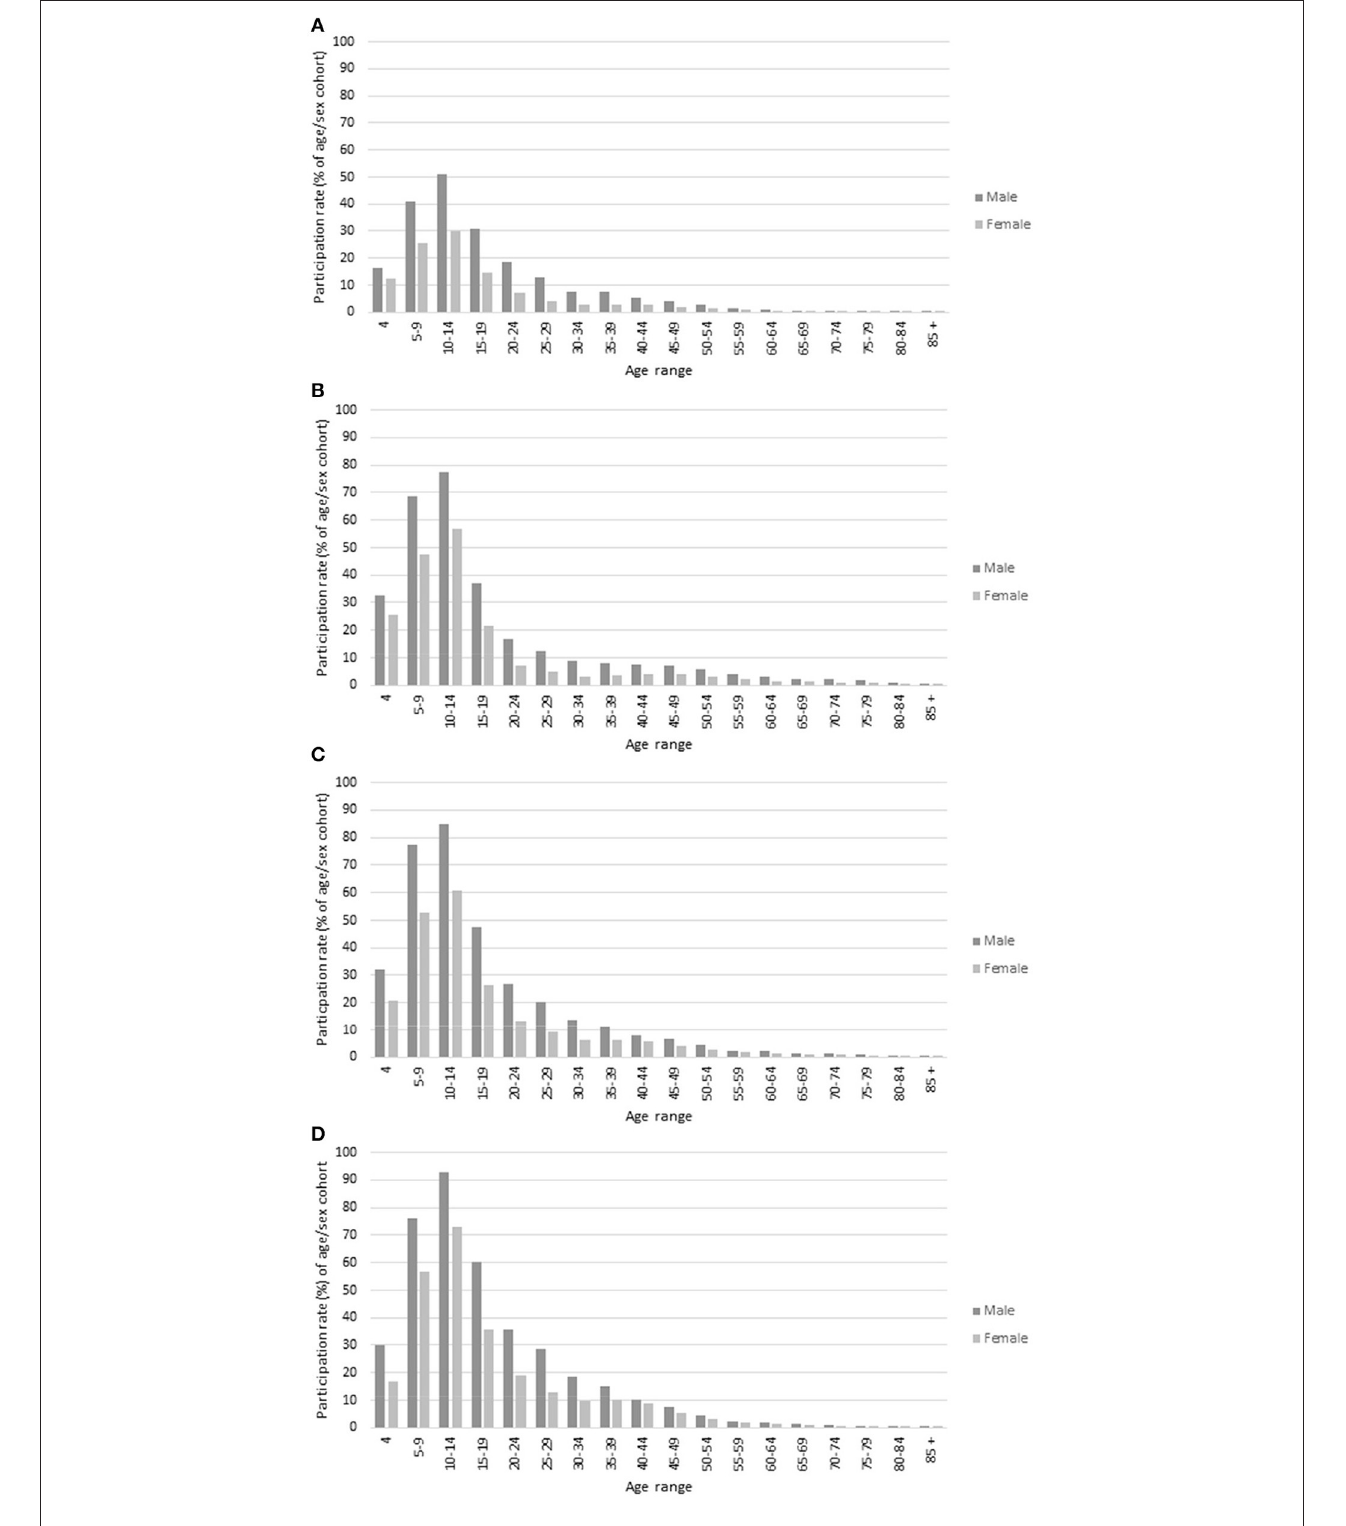
FIGURE 3 | Participation rates, 2019: by region, sex, and age. (A) Metropolitan—Growth, (B) Metropolitan—Other, (C) Regional—Growth, and (D) Regional—Other.